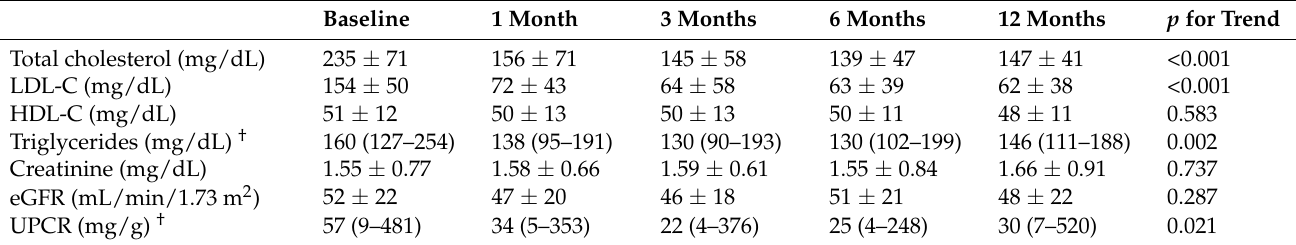
Table 2. Evolution of lipid and renal profiles during